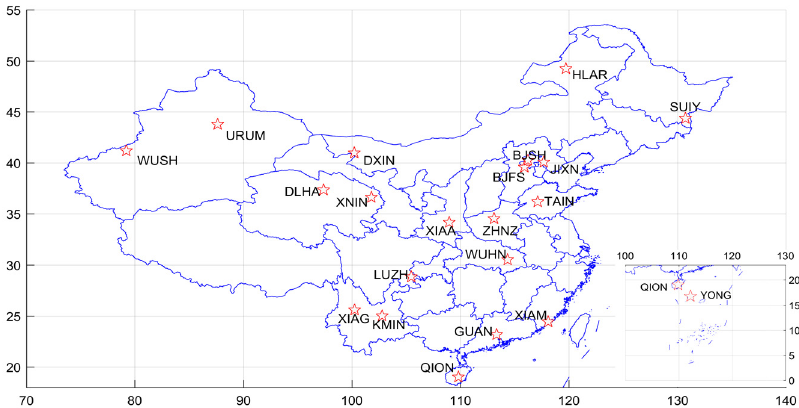
Figure 1. The locations of the 21 selected GNSS sites from CMONC.